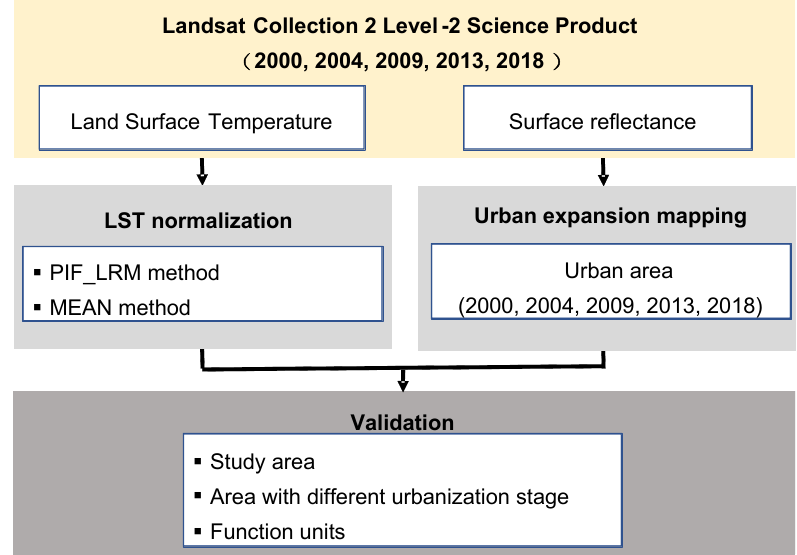
Figure 4. Workflow of the study.